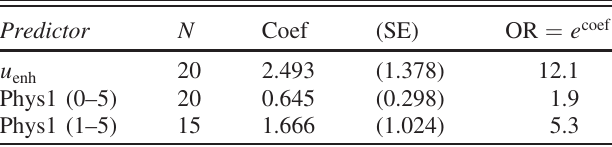
TABLE VIII. Comparison of logistic regressions for sta- tistically significant predictors ( p < 0 . 05 ) the individual level enhancing emotions ( u ), and the grade of Phys1 in two enh different scales, with retention as the outcome. Odds ratio for enhancing emotions as the predictor is the highest. The intercept values are omitted as